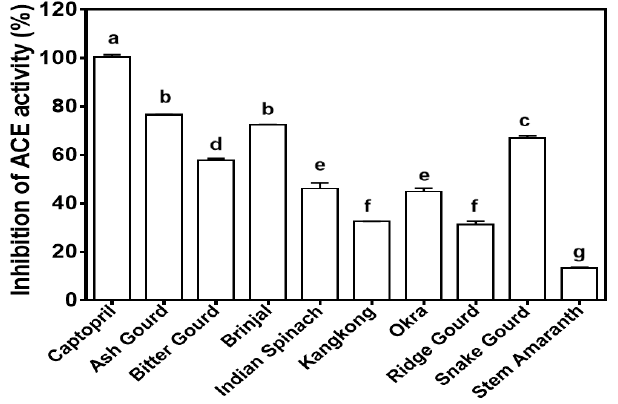
Figure 4. Inhibition of angiotensin-converting enzyme (ACE) activity ( n = 3 ± standard deviation) by 1 mg / mL captopril and aqueous polyphenolic extracts of vegetables. Bars with di ff erent letters have mean values that are significantly ( p < 0.05) di ff